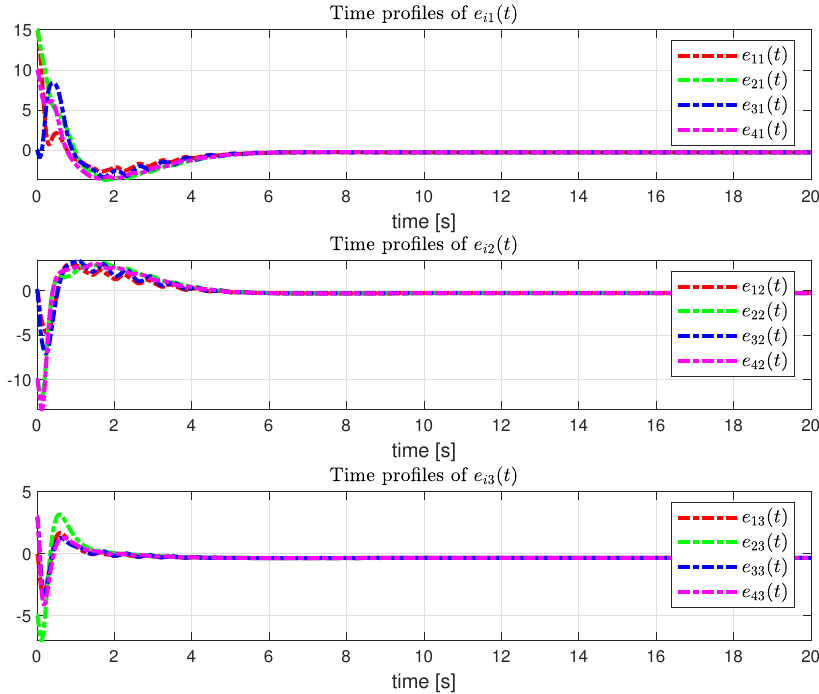
Figure 6. Absolute tracking errors of all of the